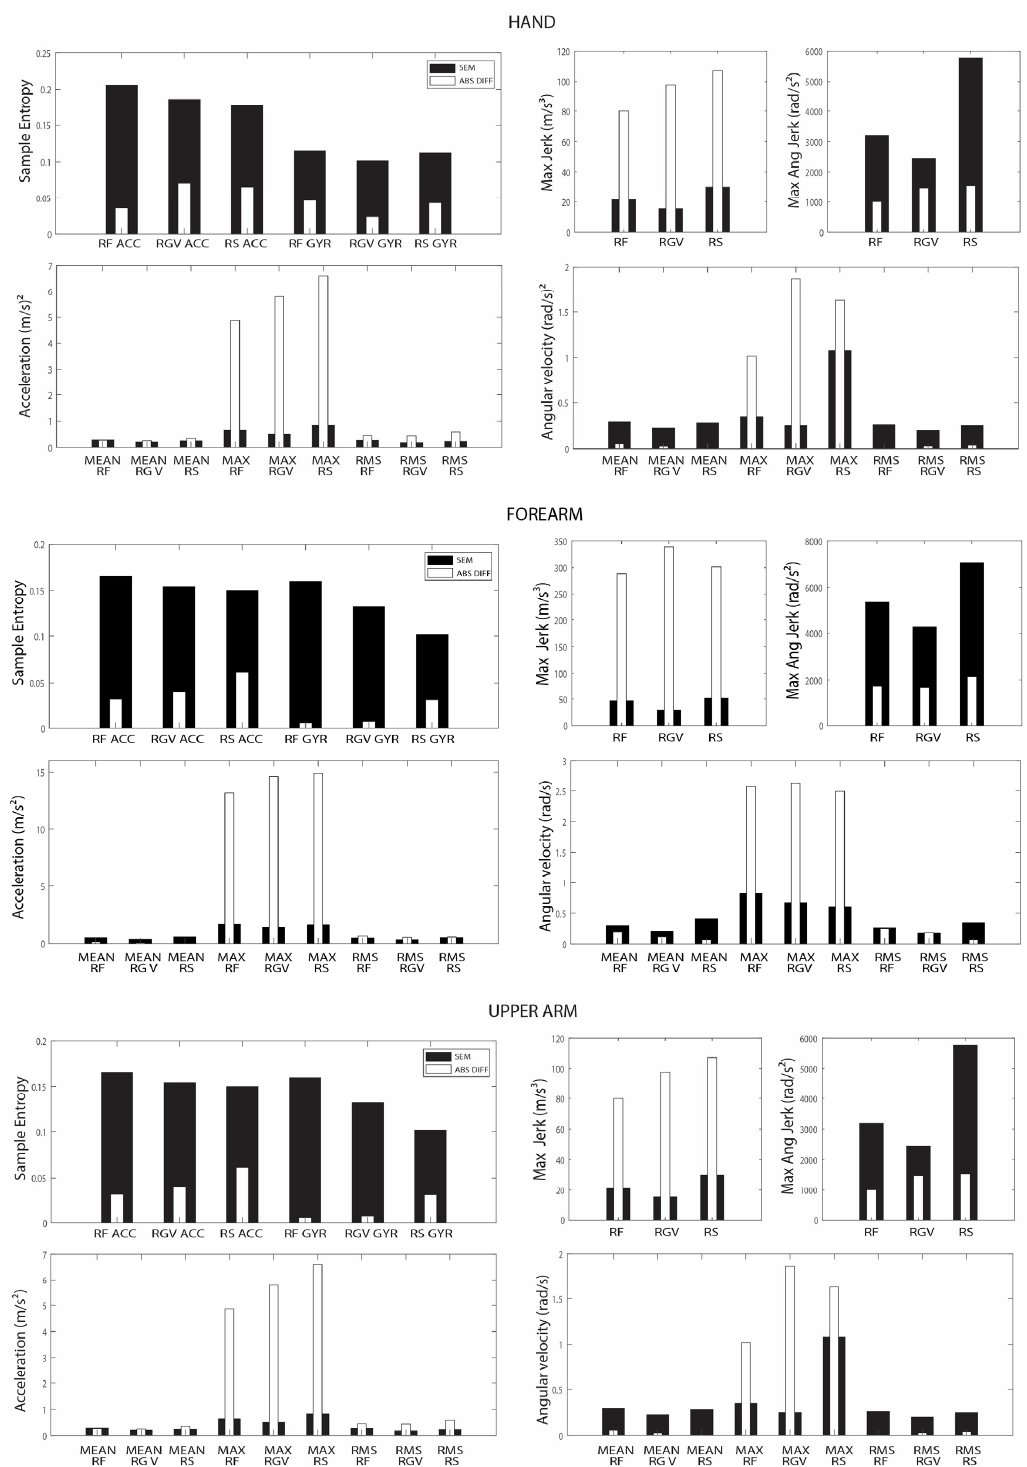
Figure 4. Between-session standard error of measurement (SEM) and absolute mean differences between the TD and DCP groups for forearm, hand, and upper arm sensors. RF = reach forward; RGV = reach-and-grasp vertical; RS = reach sideways; MAX = maximal; RMS = root mean square. SEM = standard error of measurement. ABS DIFF = absolute